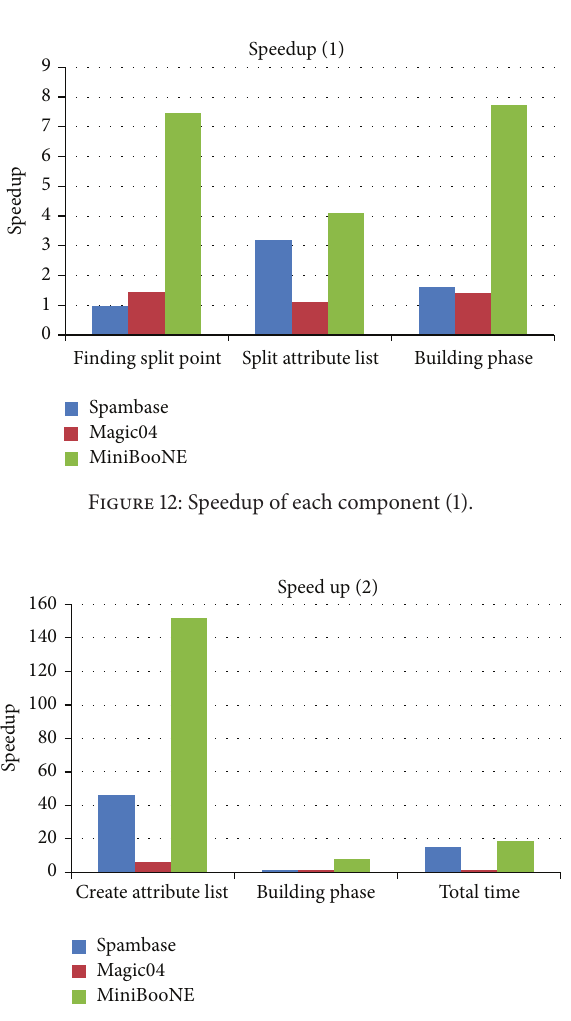
Figure 13: Speedup of each component